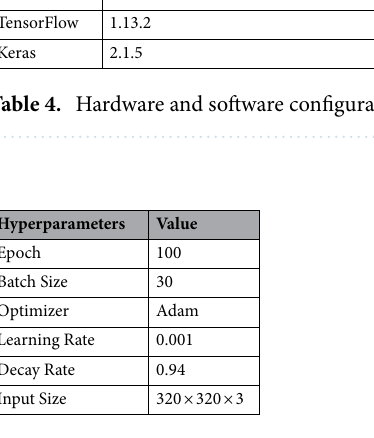
Table 5. Hyperparameters for model training.